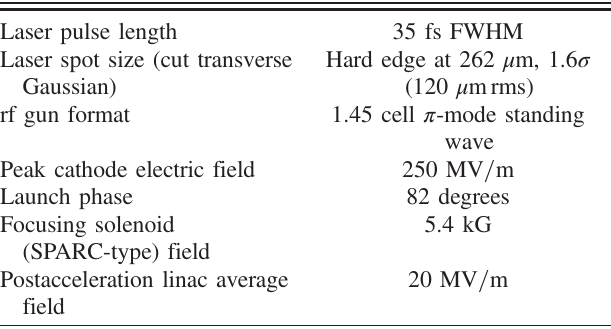
TABLE I. Parameters for blowout regime beam dynamics